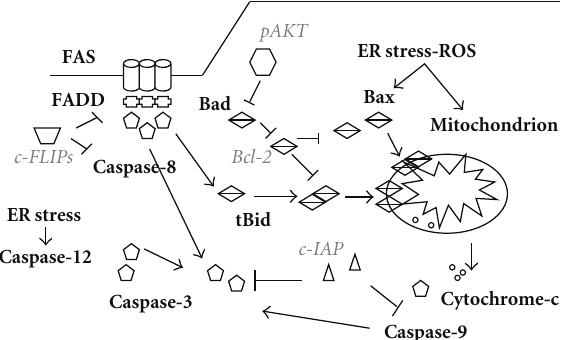
Figure 1: Major apoptotic pathways. Schematic representation of intrinsic, mitochondrial, and extrinsic, death receptor, pathways. Proapoptotic molecules are in bold and antiapoptotic are in italic